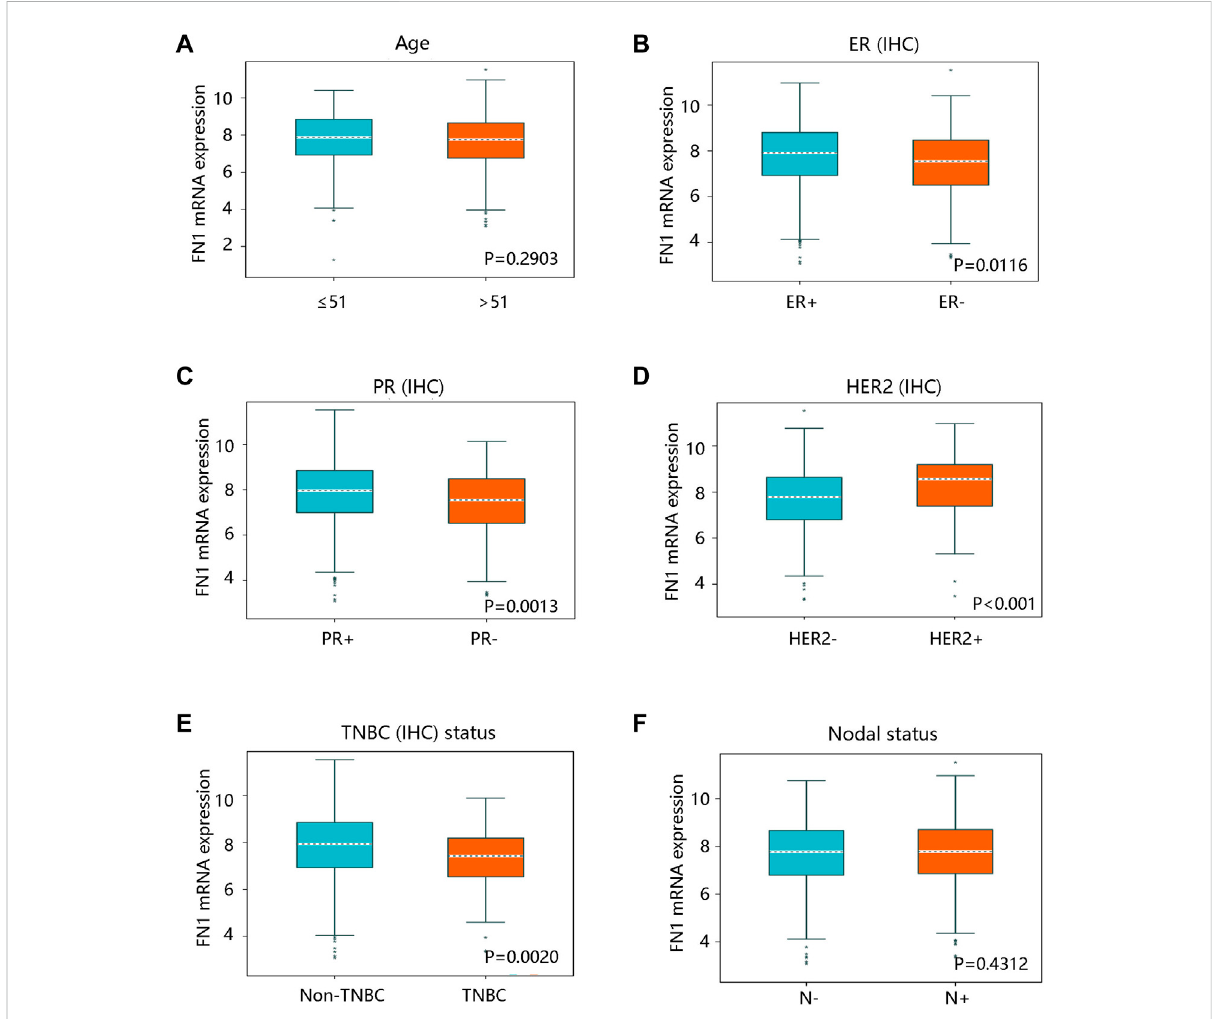
FIGURE 3 The relationship between FN1 mRNA expression and clinicopathological characteristics in breast cancer in bc-GenExMiner v4.8 database. (A) The association of FN1 expression with age with no statistical signi fi cance. FN1 expression was signi fi cantly related to (B) ER status, (C) PR status, (D) HER2 status, and (E) TNBC status. (F) No remarkable relationship between FN1 expression and nodal status. IHC; immunohistochemistry; ER, estrogen receptor; PR, progesterone receptor; HER2, human epidermal growth factor receptor 2; TNBC, triple-negative breast